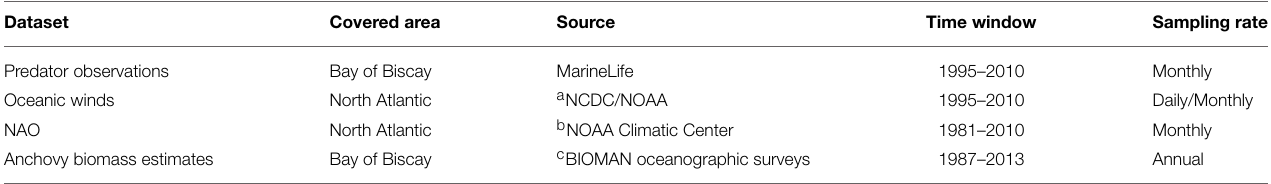
TABLE 1 | Description of the dataset used for understanding the role of climate and food availability on driving decadal abundance patterns of highly migratory marine predators in the Bay of